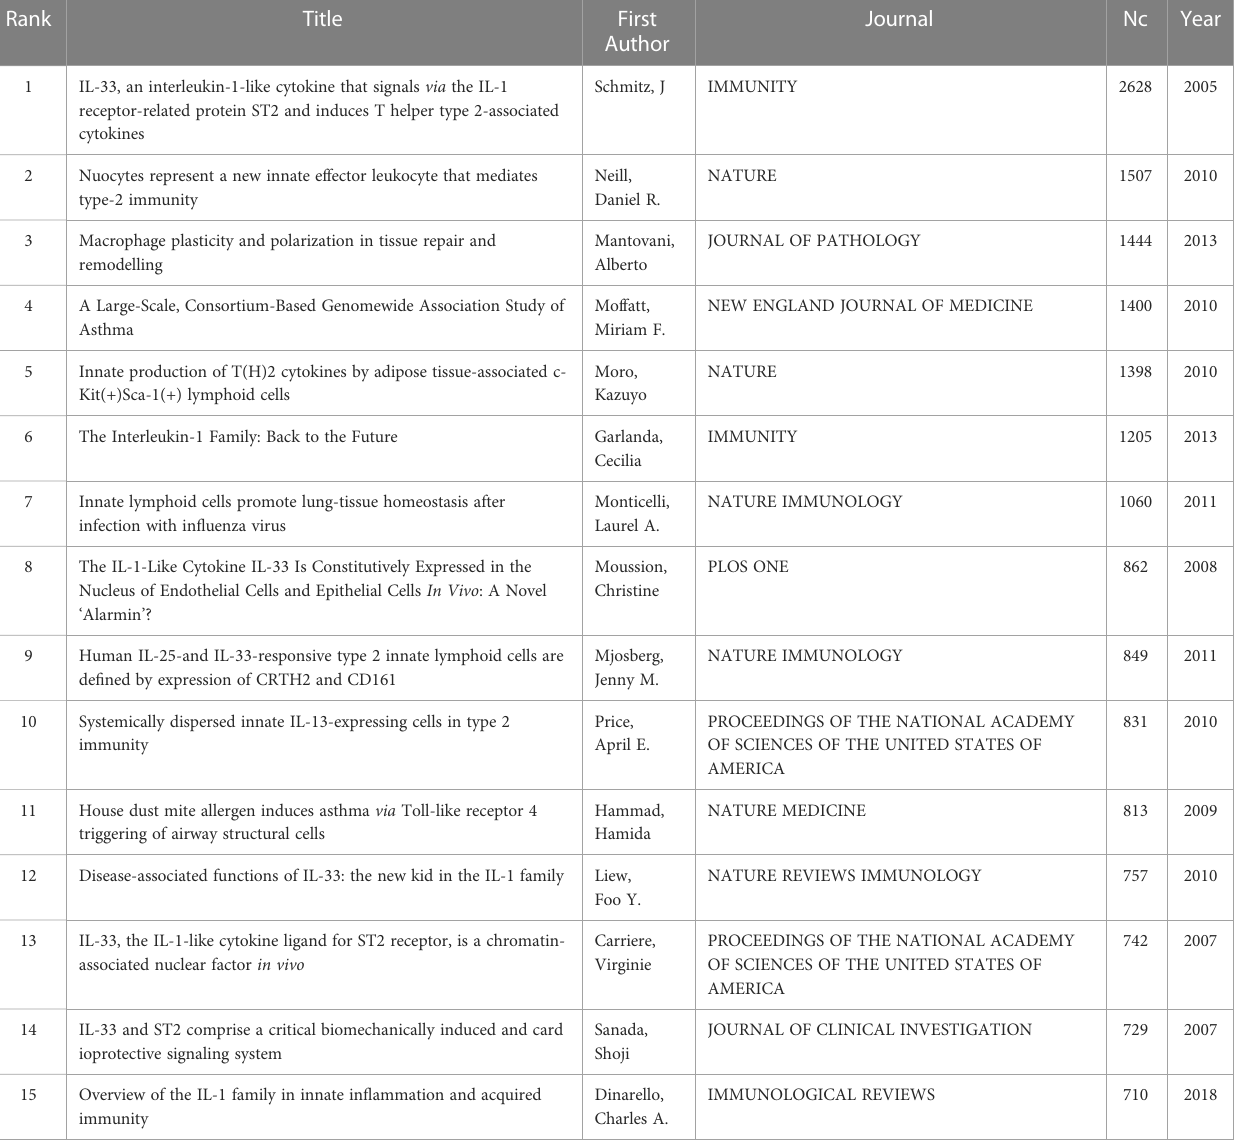
TABLE 5 The top 10 co-cited references concerning